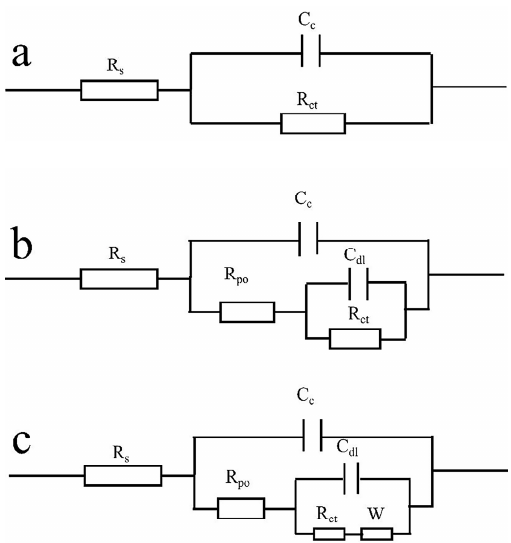
Figure 7. Equivalent electrical circuits models.